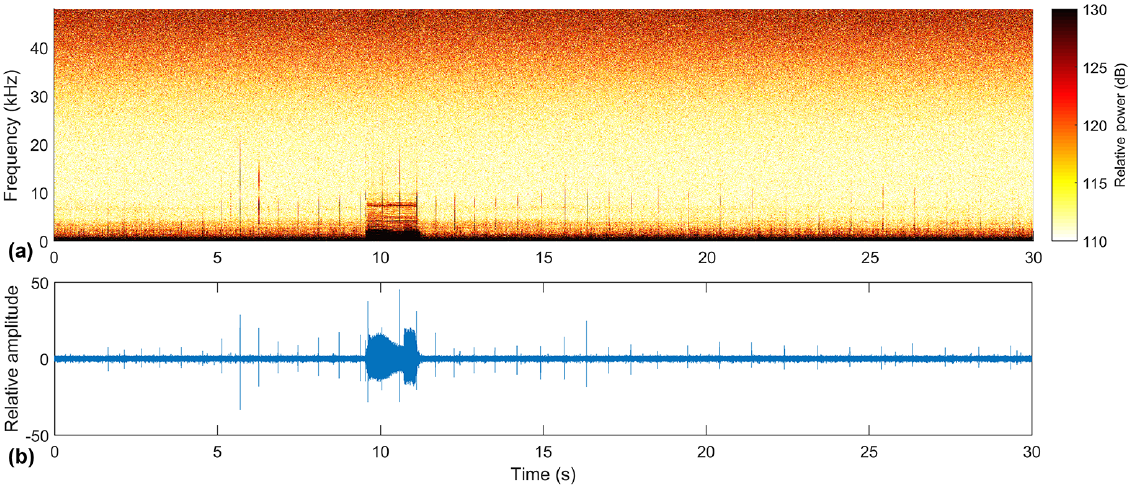
Figure 11. Spectrogram (a) and time series (b) showing an example of noise produced by the pitch pump, which makes small adjustments to the battery position during a dive. Sperm whale echolocation clicks can also be observed in this sequence, especially in the time series data.